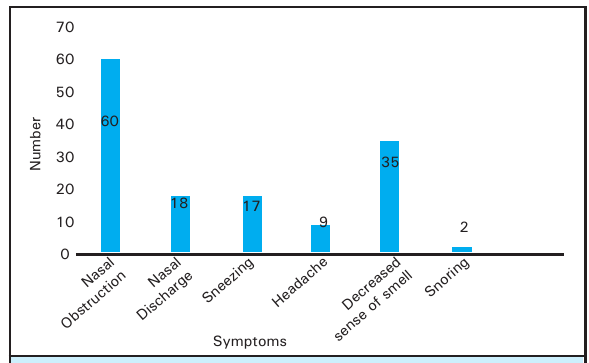
Figure 1. Frequency of symptoms at